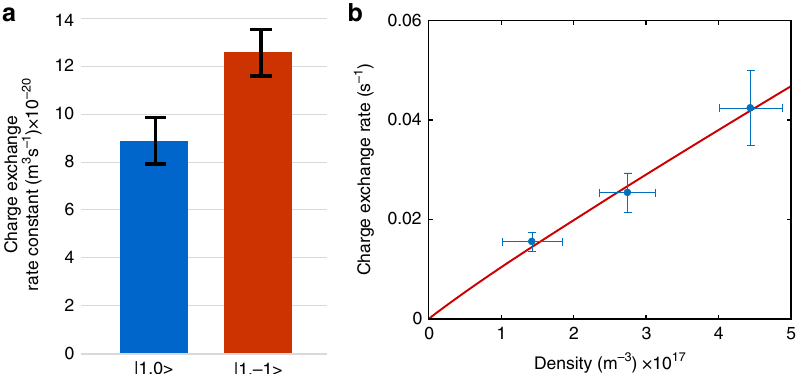
Fig. 3 Charge-exchange control. a Charge-exchange rate for different initial hyper fi ne states of Rb atoms. b Density dependence of the charge-exchange rate averaged for 1 ; 0 j i and 1 ; (cid:3) 1 Rb